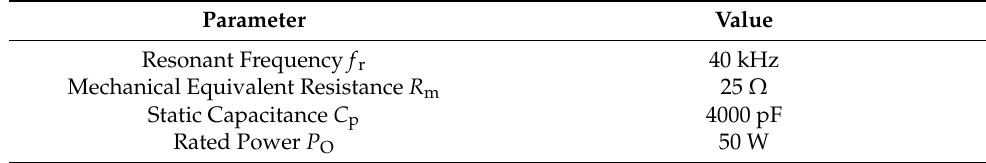
Figure 15. A photograph of the proposed prototype drive circuit for supplying a piezoelectric ceramic actuator. Table 3. Parameters of the utilized piezoelectric ceramic actuator.